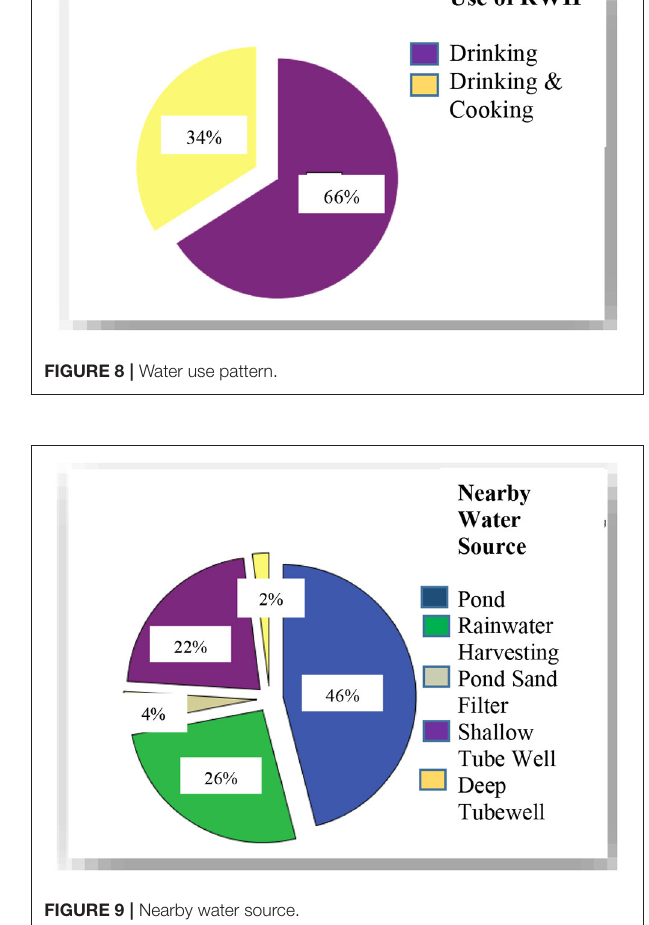
FIGURE 9 | Nearby water